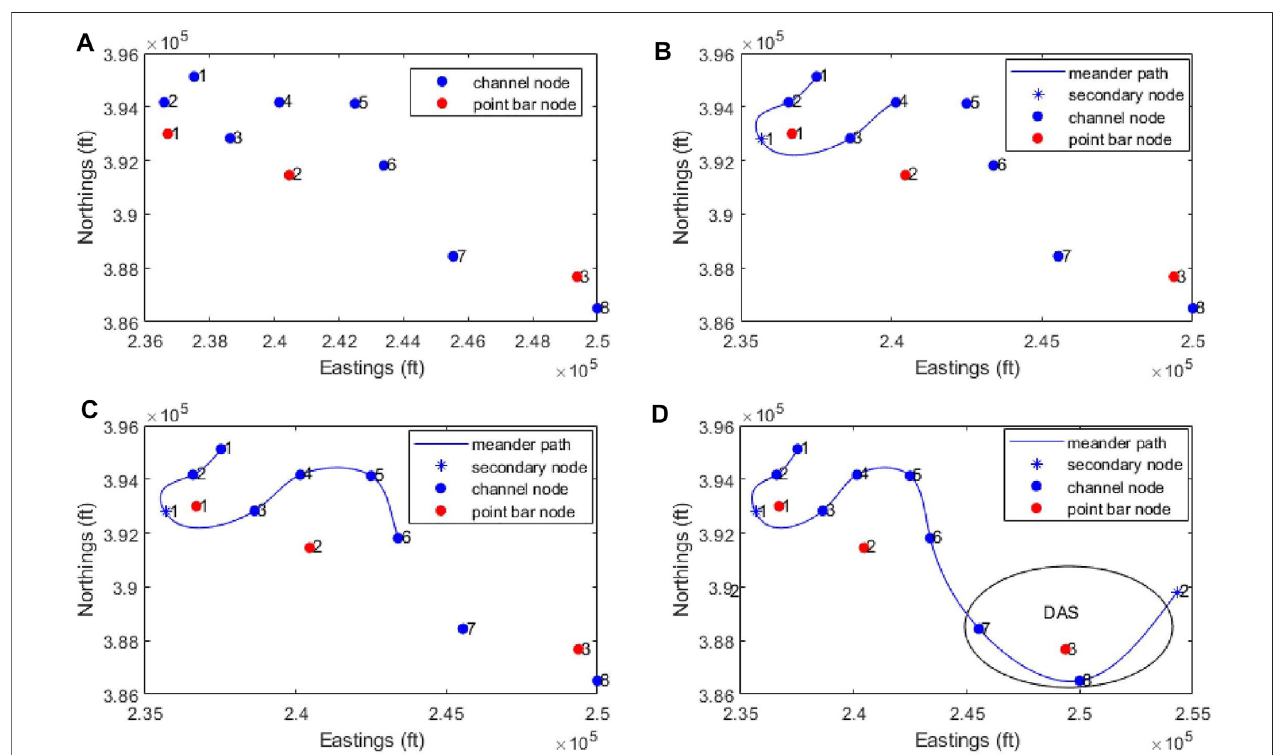
FIGURE3| Channel path simulationforthe Cran fi eld dataset, (A) Modelling stage1-Locations forthe point bar (red) and channel facies(blue)interpretedusing SP logs, (B) Modelling stage 2-channel path recreation begins. secondary node is inserted to guide the channel path, (C) Modelling stage 3 and (D) fi nal Modelling stage- channel path follows the channel nodes sequentially until all the well data is accommodated. The circled area in the fi nal fi gure is the Detailed Area of Study(DAS) at the Cran fi eld injection site.